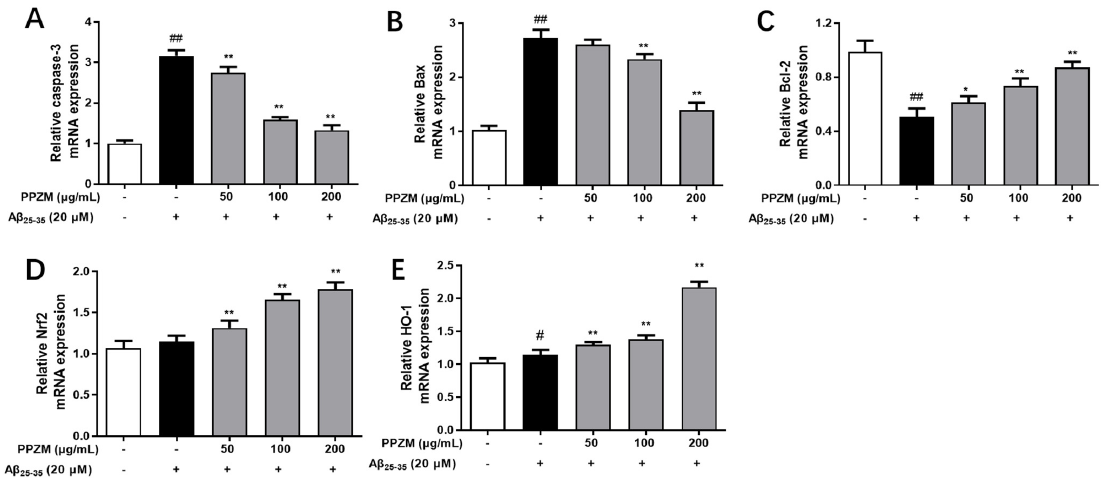
Figure 6. Effect of PPZM on A β 25–35 -induced apoptosis-related and Nrf2/HO-1 mRNA expression in PC12 cells. RT-qPCR analysis of caspase-3 ( A ), Bax ( B ) and Bcl-2 ( C ), Nrf2 ( D ), and HO-1 ( E ) mRNA expression in PC12 cells. Results are expressed as the mean ± SD. # p < 0.05, ## p < 0.01 vs. the control group; * p < 0.05, ** p < 0.01 vs. the A β 25–25 treated group.